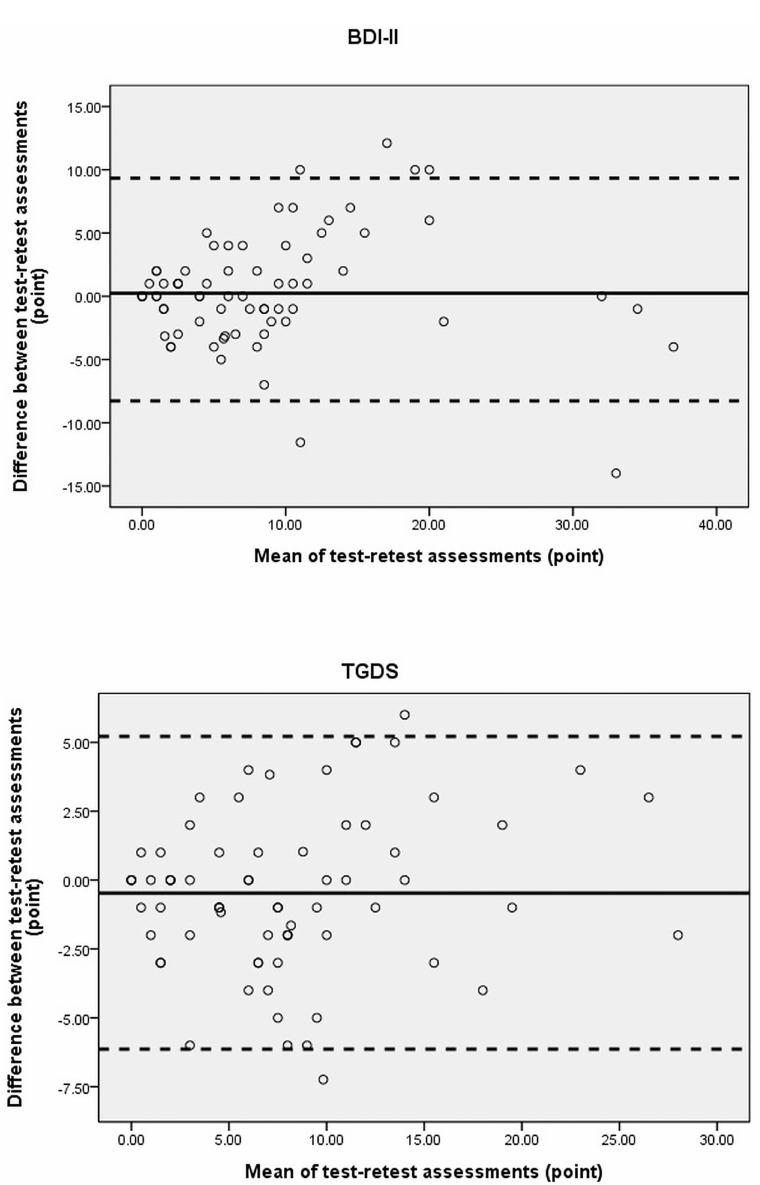
Fig 1. Bland & Altman plots of the difference scores against the mean scores of each pair of the BDI-II and the TGDS. The solid line representsthe mean of the differences. The 2 dashedlines define limits of agreement (mean of the difference ± 1.96